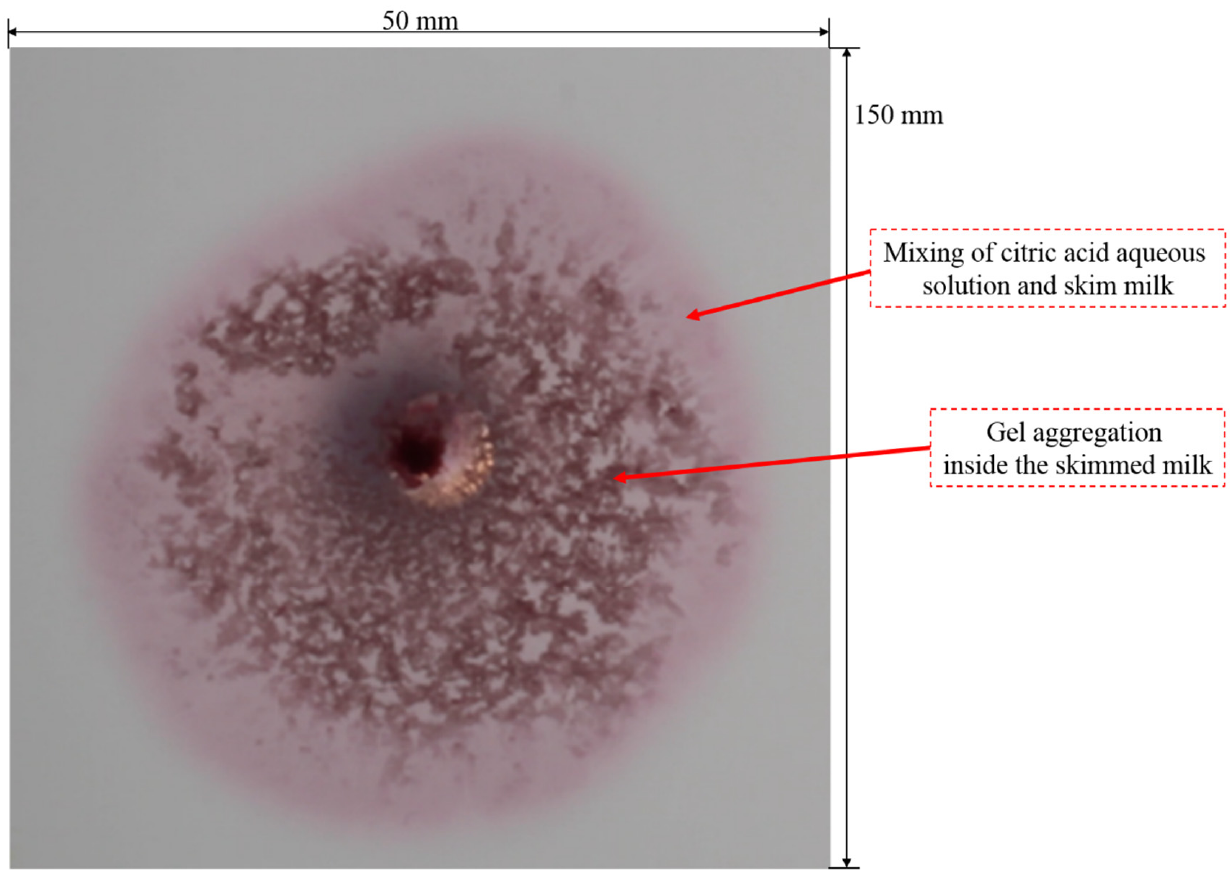
Figure 7. Displacement pattern when the skim milk doped with methyl red is injected into the aqueous citric acid solution. The dark red part is the gel resulting from precipitated casein micelles, whereas the pink part is the water separated from the gel. The image was captured at the initial injection stage when the skim milk was injected into the aqueous citric acid solution, and the skim milk injection volume was 0.4 mL. The citric acid concentration c was 15 wt% at an injection rate Q of 15 mL/h and a gap width b of 0.4 mm.